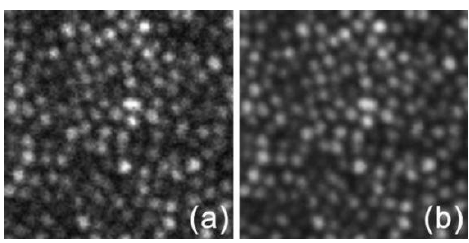
Figure 3. AO-SLO image ( a ) before and ( b ) after denoising using proposed method based on TV- L1 optical flow registration. optical flow